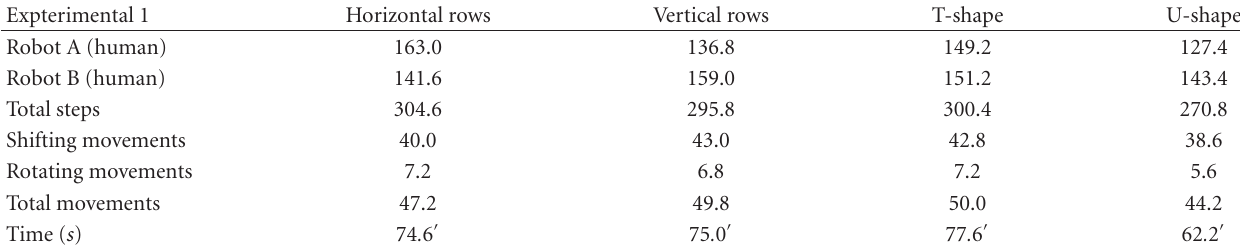
Table 2: Two human-controlled robots (control case).